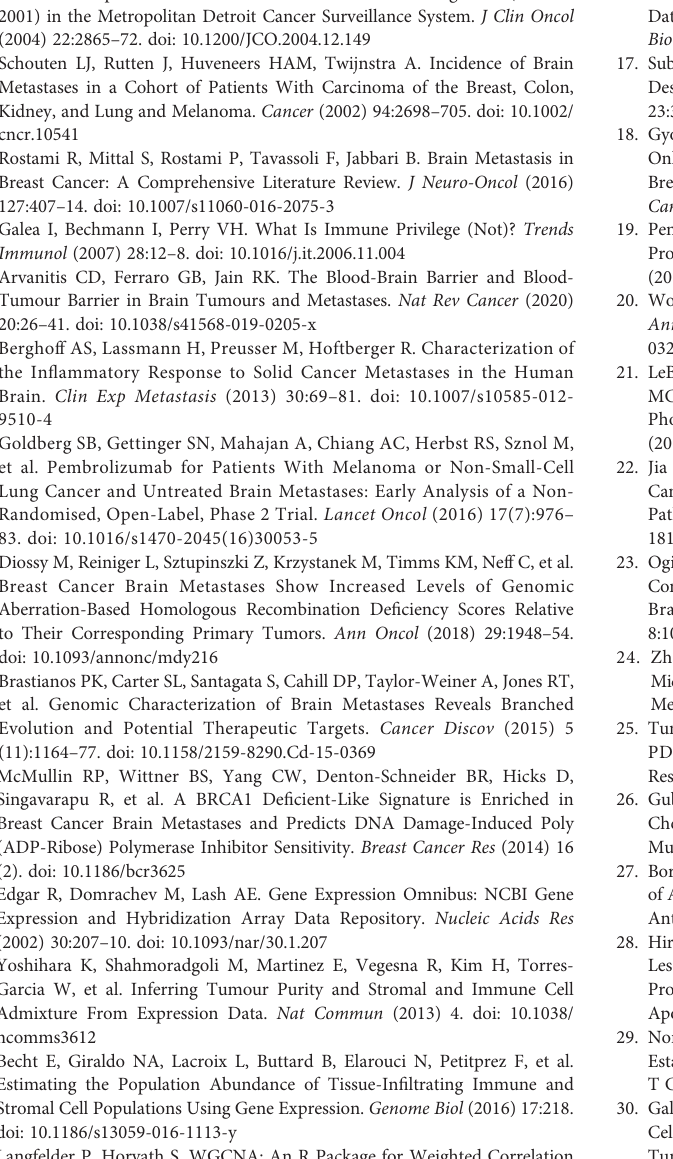
Supplementary Table 3 | Genes of the turquoise module that was signi fi cantly correlated with immune in fi ltration of the sample. Supplementary Table 4 | The results of DEGs crossed with genes in turquoise. Supplementary Table 5 | The results of gene set enrichment analysis in BCBMs compared with BCs (GSE43837). The normalized enrichment score (NES) represented the degree of enrichment of the KEGG pathway in BCBMs compared with BCs. P values corresponding to each NES were determined by the Fisher ’ s exact test (1000 permutation) in GSEA. Adjusted P values corresponding to each NES were determined by Benjamini-Hochberg (BH) correction in GSEA.